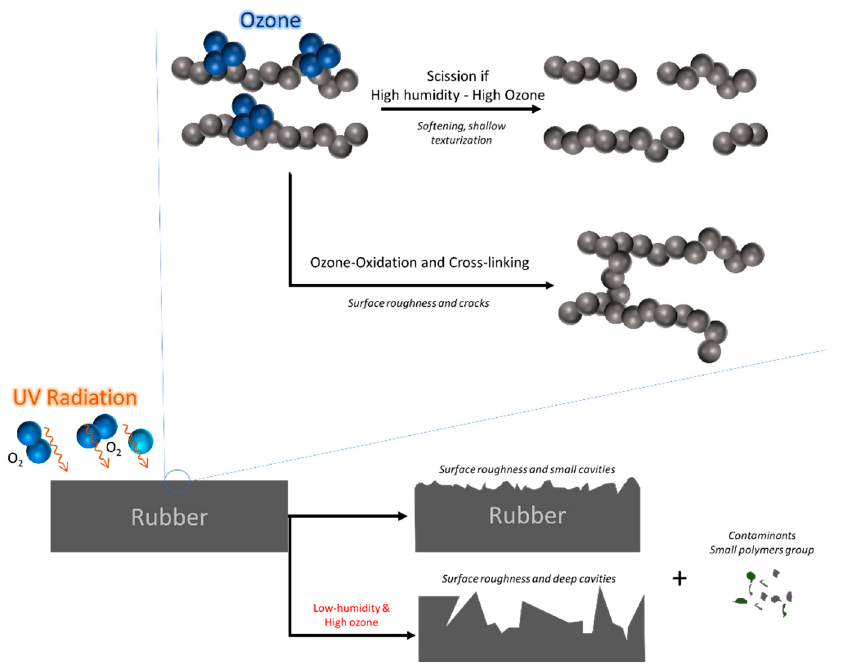
Figure 6. Simplified scheme of the ozone reaction initiation and effect on rubber surface.